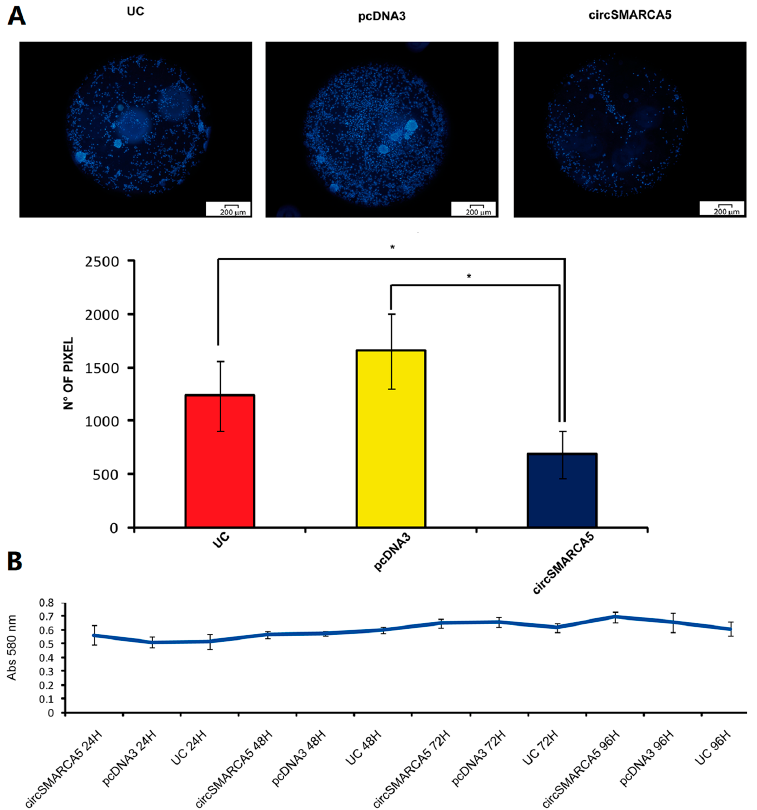
Figure 3. Effects of circSMARCA5 overexpression on migration and viability of U87MG cells. ( A ) Migration of untransfected (UC), pcDNA3 and pcDNA3_circSMARCA5